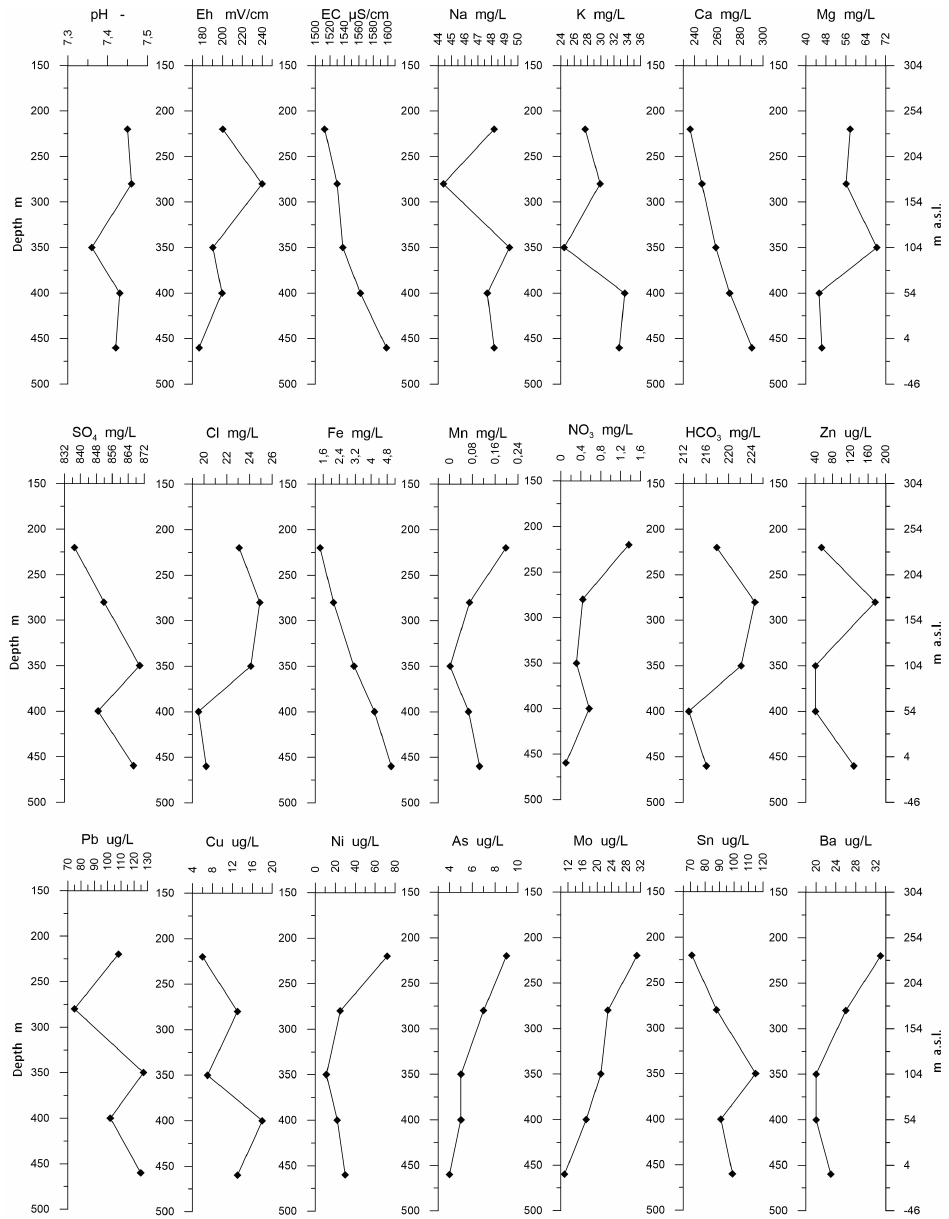
Figure 7. Vertical variability of physicochemical parameters and concentrations of specific ions in water samples from the “Nowy I”